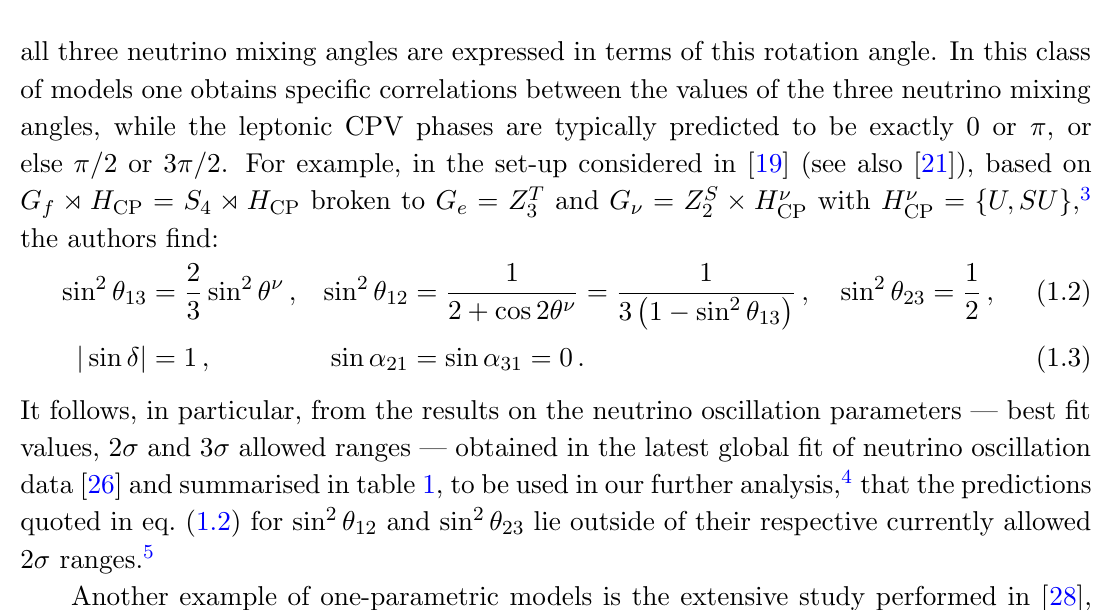
Table 1 . The best (cid:12)t values, 2 (cid:27) and 3 (cid:27) ranges of the neutrino oscillation parameters obtained in the global analysis of the neutrino oscillation data performed in